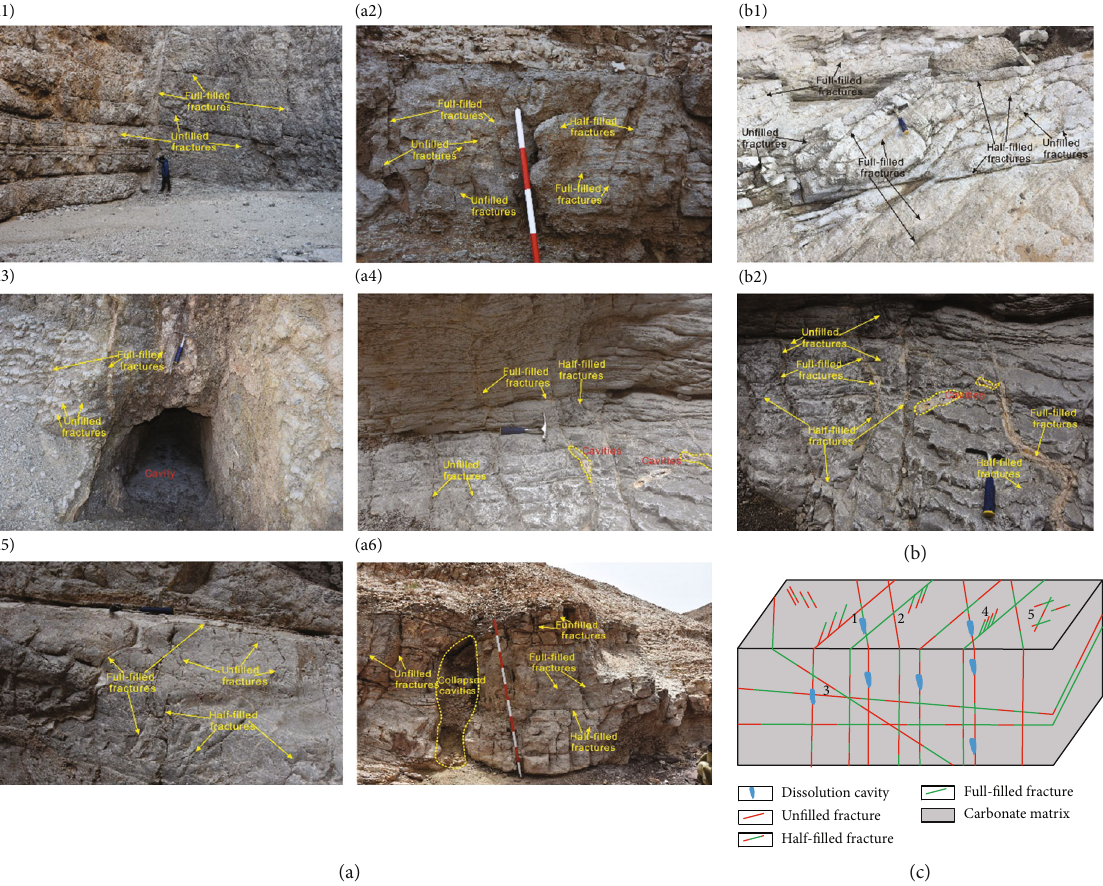
Figure 2: Schematic of conceptualizing fracture fi lling formation as a fracture-cavity-matrix system with well di ff erent-level mineral veins. -a ) Pro fi le outcrop pictures, (b (a 1 6